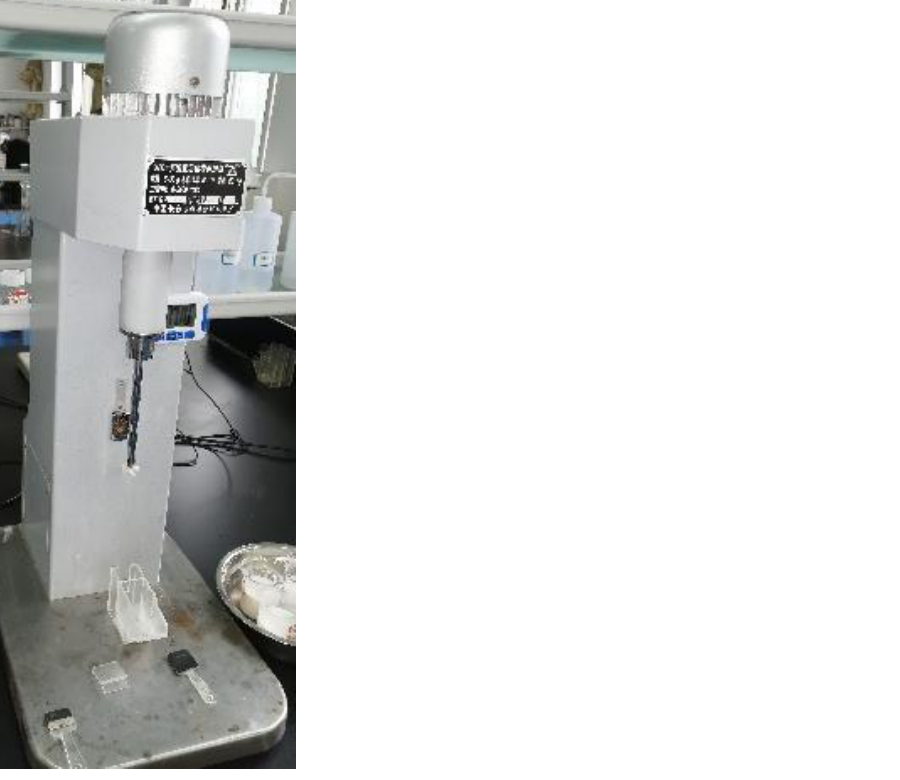
Figure 2. XFG − 40 mL flotation machine with the flotation cell, dam board, and scraper.